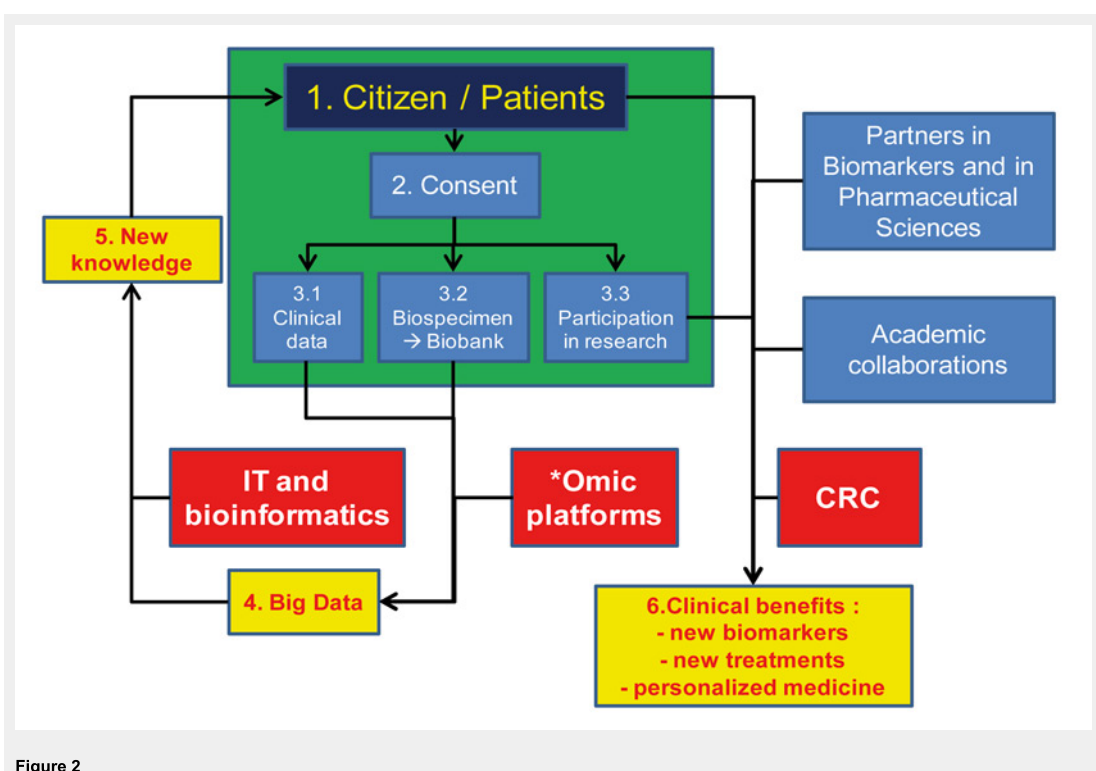
Figure 2 Role of bio-resources like BIL in catalysing translational research. Emerging *omic technologies (genomics, transcriptomics, metabolomics and others) require access to high-quality data and samples from large number of individuals engaged in research and properly consented for the use of their data and specimen. These technologies generate large amounts of data (i.e. Big Data), which are converted into new knowledge thanks to information technology (IT) and bio-informatics. For their clinical utility to be demonstrated, evidence needs to be built, using clinical research on engaged citizens and in partnership with other academic groups within the private sector. The perimeter of the BIL is illustrated using the green rectangle. CRC = clinical research